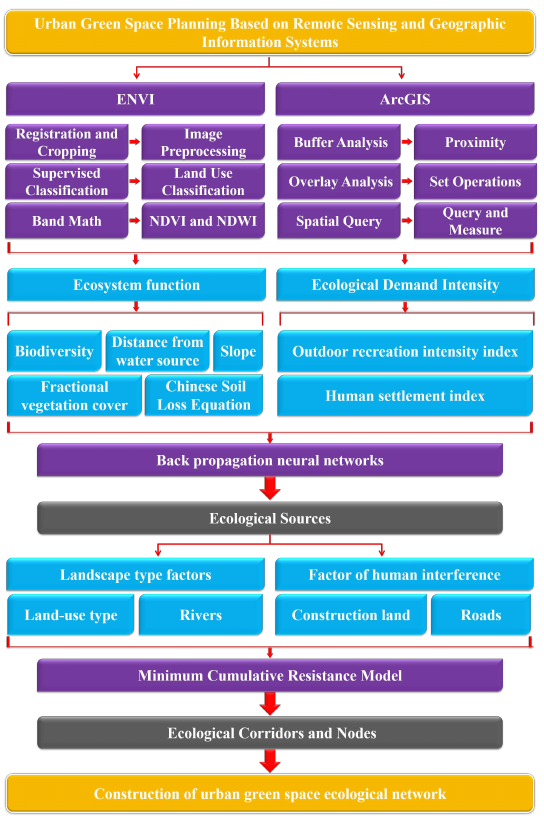
Figure 2. Analytical steps in the construction of the urban green space ecological network using RS, GIS, and BP neural networks minimum cumulative resistance model. Orange refers to the main research content and results of the article, purple is the main method used, blue is the main factor in the study, and gray is the results of each stage of the study. ENVI combines band-based and file-based techniques using interactive functions, providing tools to convert image data into map formats, ENVI combined with ArcGIS, in the construction of urban green spaces, which provides comprehensive data visualization and analysis for all types of images [57]. In this study, ENVI was used to preprocess re- mote sensing images from Landsat8 satellite data, including image registration and crop- ping. The Maximum Likelihood Estimate (MLE) was used for supervised classification, and the classification of land use in the study area was obtained through class definition, sample selection, image classification, result processing and verification, after which the accuracy of the classification results was evaluated. In addition, using Band Math, by in- putting the near-infrared band, red band, green band, and near-infrared band, the NDVI and NDWI values were obtained and analyzed, providing the basis for subsequent related research. Using spatial analysis in ArcGIS, it can perform spatial data operations and spa- tial data analysis methods such as distance, area, path calculation, buffer analysis, spatial query, and overlay analysis to identify, extract and quantify various urban green space landscape elements. The index elements and their distribution rules are displayed in a visual way, the geographic location and spatial relationship of each landscape element are more intuitively displayed, and the results of planning and design are simulated and an- alyzed. Through the processing of geographic information, the characteristics of urban green space landscape elements are comprehensively expressed in multi-level and multi- form.